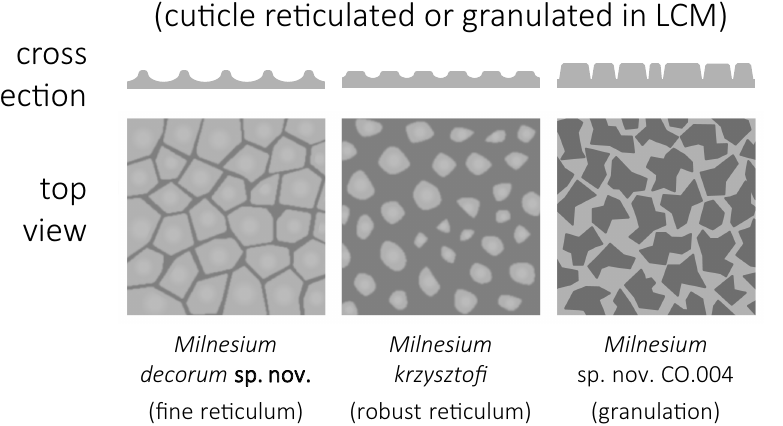
Figure 8. Schematic drawings showing different types of epicuticular sculpturing in the Milnesium granulatum morphogroup (based on LCM and SEM observations). The top panel shows cross sections through the cuticle surface, whereas the bottom panel shows top views on the cuticle surface (darker grey indicates thicker cuticle/ elevated surface). The left panel shows a fine reticulum with thin walls and wide meshes ( M. decorum sp. nov. ), the middle panel shows a robust reticulum with thick walls and small meshes ( M. krzysztofi and the great majority of species of the granulatum morphogroup), and the right panel shows granulation ( Milnesium sp. nov. CO.004).